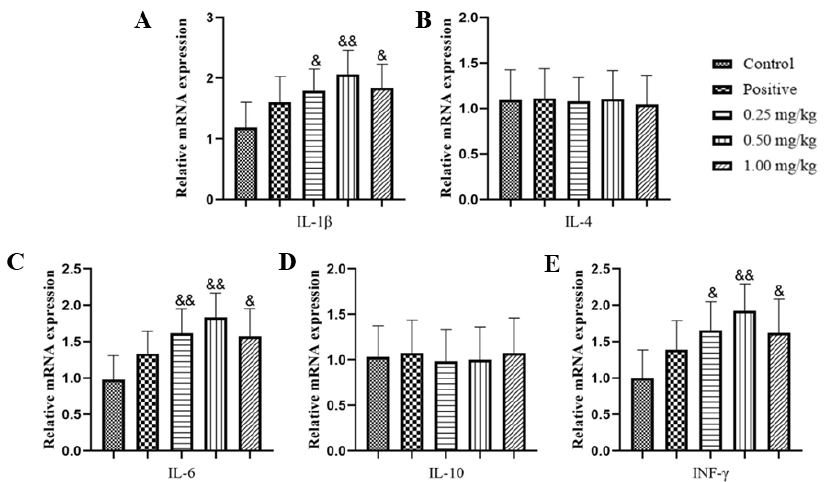
Figure 3. Expression of ( A ) IL-1 β ; ( B ) IL-4; ( C ) IL-6; ( D ) IL-10; and ( E ) INF- γ in the liver of mice administered with avian influenza virus H9N2 vaccine and glycine nano-selenium. Bars are repre- sented as mean ± SD. Bars with same && or & are statistically the same (n = 5, p < 0.05 or p < 0.01). Control, received no immunization + 0.5 mL normal saline; positive, received H9N2 AIV vaccine + 0.5 mL 0.9% normal saline; 0.25 mg/kg group, received H9N2 AIV vaccine + 0.5 mL 0.25 mg/kg selenium solution; 0.5 mg/kg group, received H9N2 AIV vaccine + 0.5 mL 0.5 mg/kg selenium solution; 1 mg/kg group, received H9N2 AIV vaccine + 0.5 mL 1 mg/kg selenium solution.